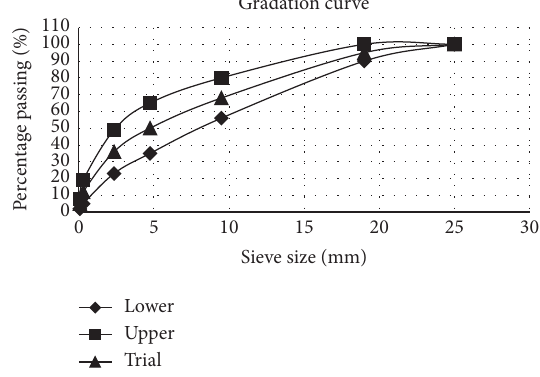
Figure 3: Aggregate